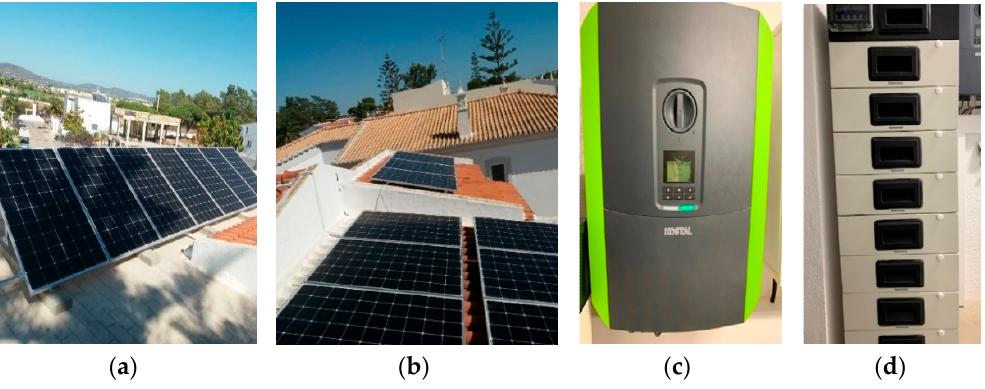
Figure 6. PV system: ( a , b ): photovoltaic panels; ( c ) inverter; ( d ) storage. The residence employed is a detached house, with two floors and with 20 different spaces. The household has a PV installation, composed of 20 Sharp NU-AK panels [50], arranged in two strings, each panel with a maximum power of 300 W. The inverter is a Kostal Plenticore Plus converter [51], which also controls a BYD Battery Box HV H11.5 (with a storage capacity of 11.5 kWh) [52]. An intelligent weather station is also installed, which measures solar irradiance and atmospheric air temperature and computes their evolution within a user-specified PH [53]. Many (several hundred) variables are acquired, either with a sampling time of 1 s or 1 min. The data acquisition system is described in the authors’ previous work and may be found in